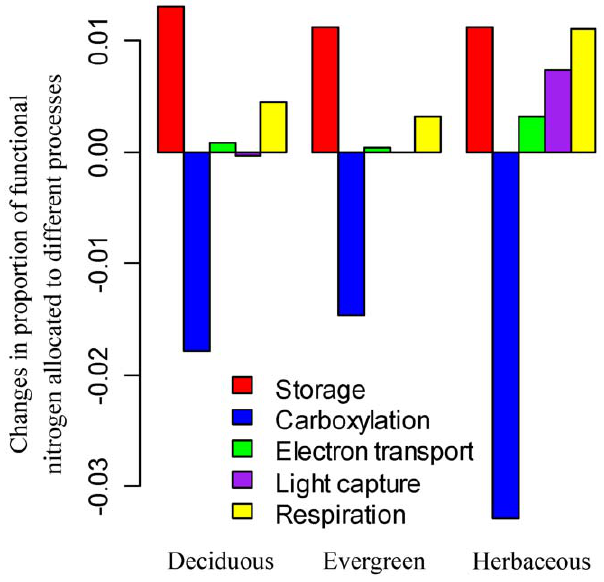
(Figure 3). By predicting nitrogen allocation coefficients under different environmental conditions, this model provides a useful tool toward a mechanistic prediction of photosynthetic acclima- tion.